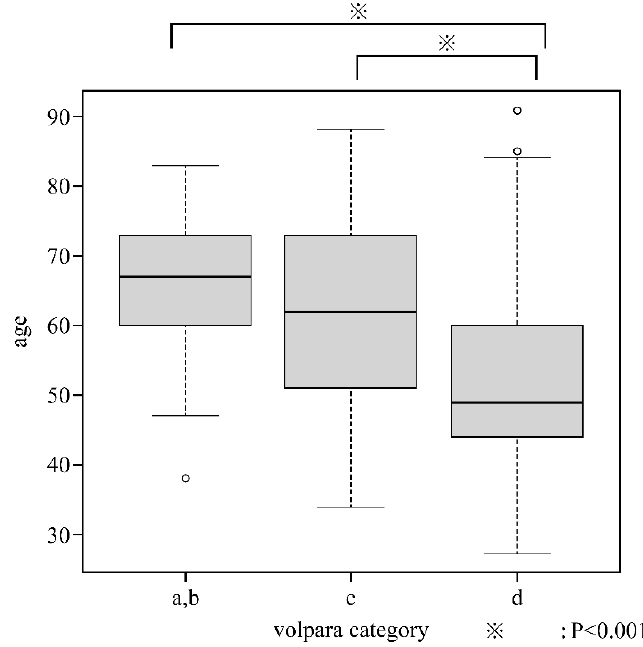
Figure 1. Relationship between Volpara Density Grade and age.